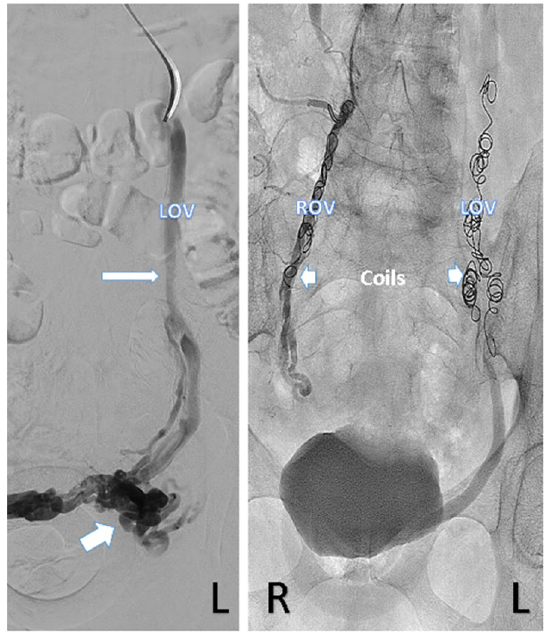
Fig. 5 Left ovarian venogram demonstrating left ovarian vein (LOV) dilatation with dilated pelvic and para uterine veins. The left ovarian vein was treated with 3% STS and coil embolization. The right ovarian vein (ROV) did not appear dilated and was treated with